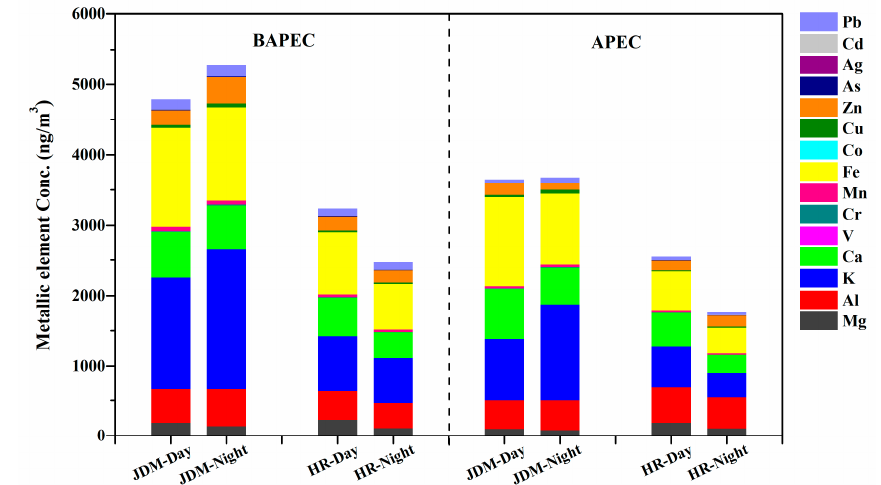
Figure 2. Daytime and nighttime concentrations of metallic elements before and during the APEC summit in Beijing urban site (JDM) and suburban site (HR).